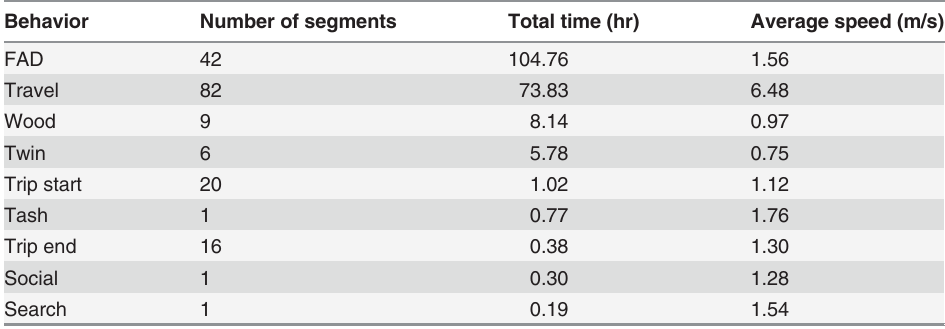
Table 3. Patches and behaviors associated with